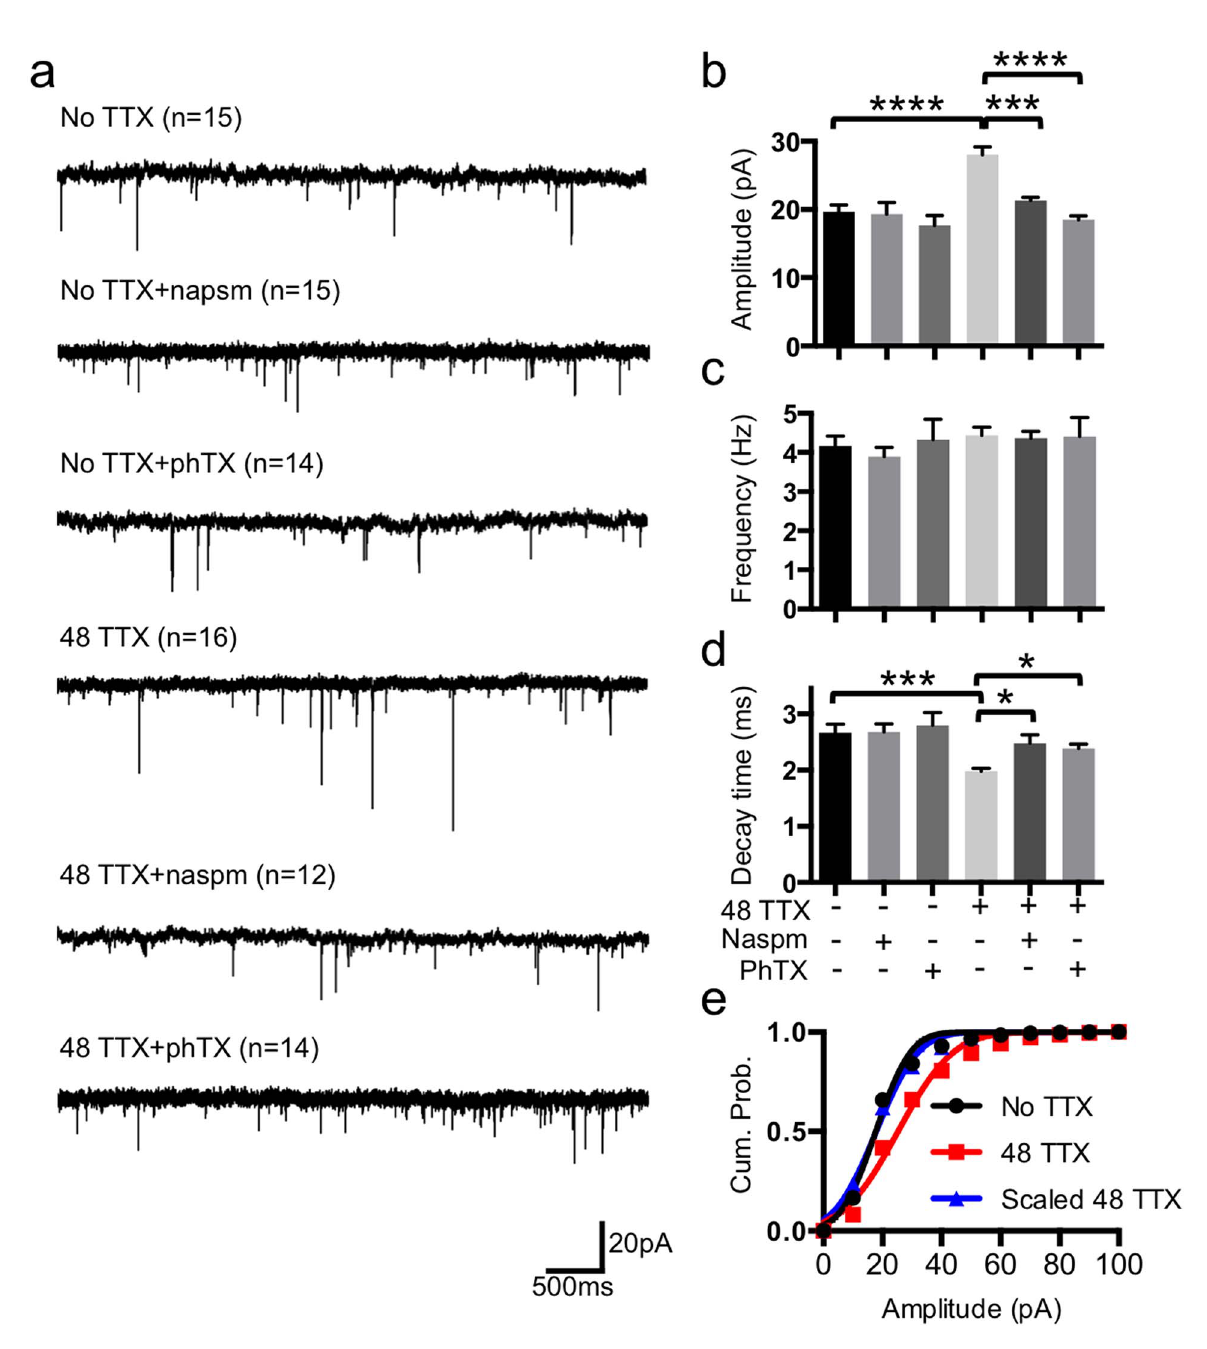
Figure 1. TTX-induced multiplicative synaptic scaling mediated by CPARs. (a) Representative traces of mEPSC recordings in each condition ( n =number of cells). (b) Average mEPSC amplitude (*** p , .001 and **** p , .0001, one-way ANOVA, uncorrected Fisher’s LSD). (c) Average mEPSC frequency. (d) Average decay time (peak to 10%) (* p , .05 and *** p , .001, one-way ANOVA, uncorrected Fisher’s LSD). (e) Average cumulative probability of mEPSC amplitude. TTX distribution is significantly different from no TTX ( p =.015, K-S test). Distribution of TTX scaled down by a factor of 1.42 fitted to no TTX distribution ( p =.935, K-S test).